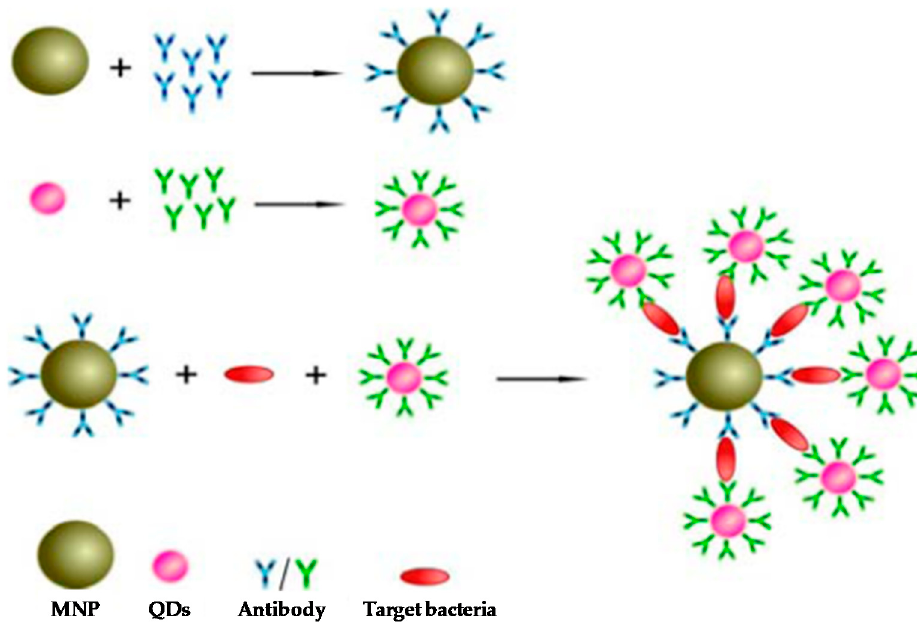
Figure 6. Schematic diagram of detection principle based on a sandwich assay using magnetic nanoparticles and quantum dots for Salmonella detection. Reprinted with permission from Int. J. Mol. Sci., 2013, 14(4), 8603. [99].